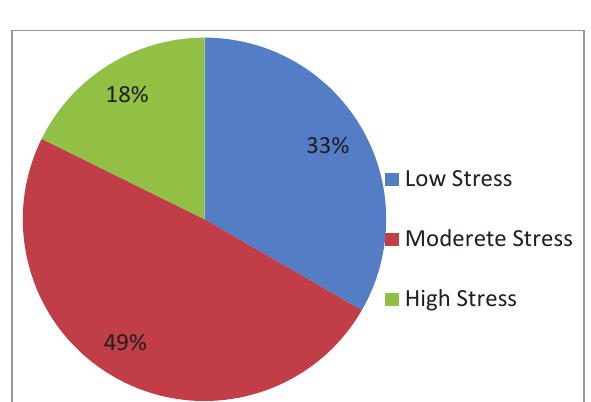
Fig-1: Categorization of Perceived Stress among both parents (n=390)